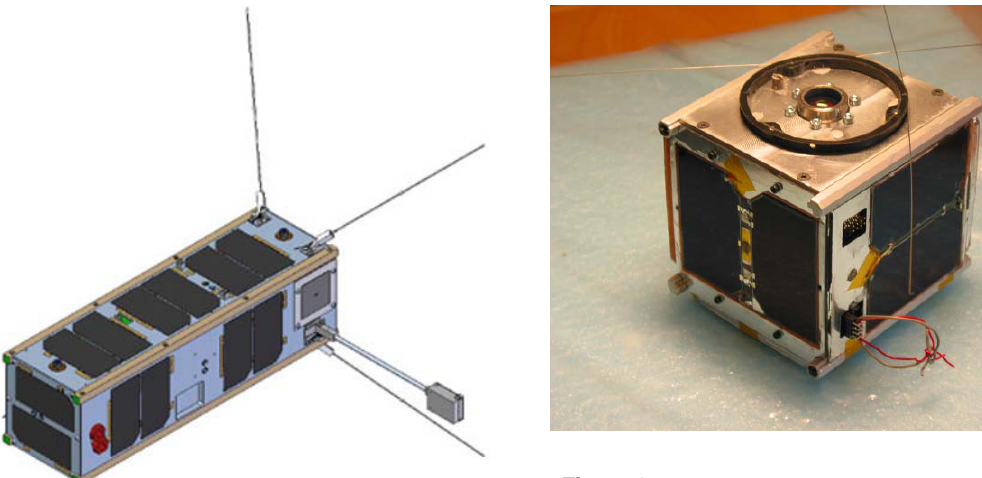
Figure 3. Fully integrated AAU-I CubeSat flight model [13].